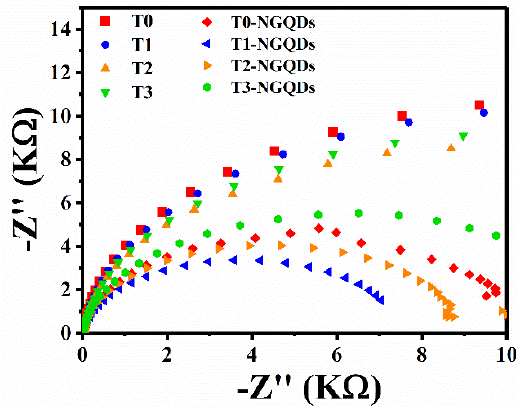
Figure 6. Electrochemical impedance spectroscopy (EIS) Nyquist plots of different TiO 2 samples without and with NGQDs decoration.